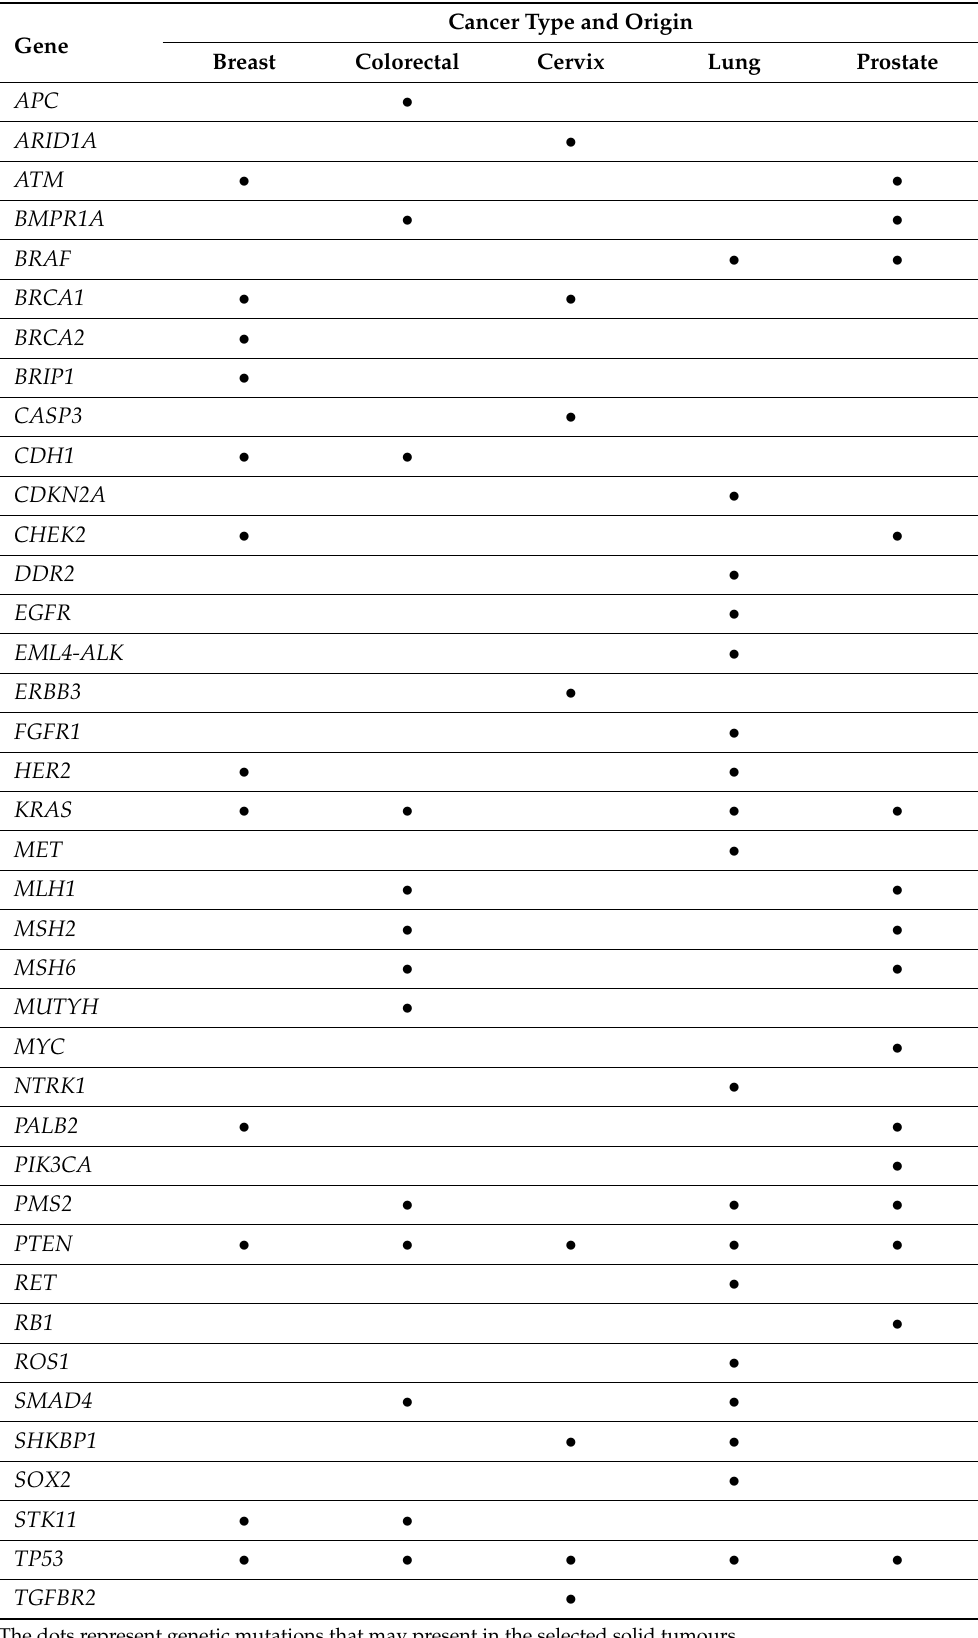
Table 1. Common genetic mutations in solid